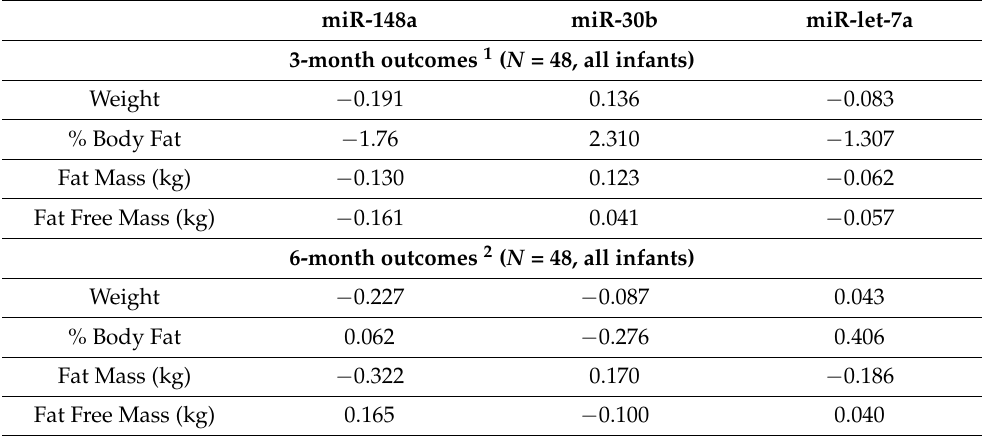
Table 3. Associations between 3-month breast milk exosomal miRNA abundance and infant outcomes at 3 and 6 months of age in infants still being exclusively breastfed. miR-148a miR-30b miR-let-7a 3-month outcomes 1 ( N = 48, all infants) Weight − 0.191 0.136 − 0.083 % Body Fat − 1.76 2.310 −